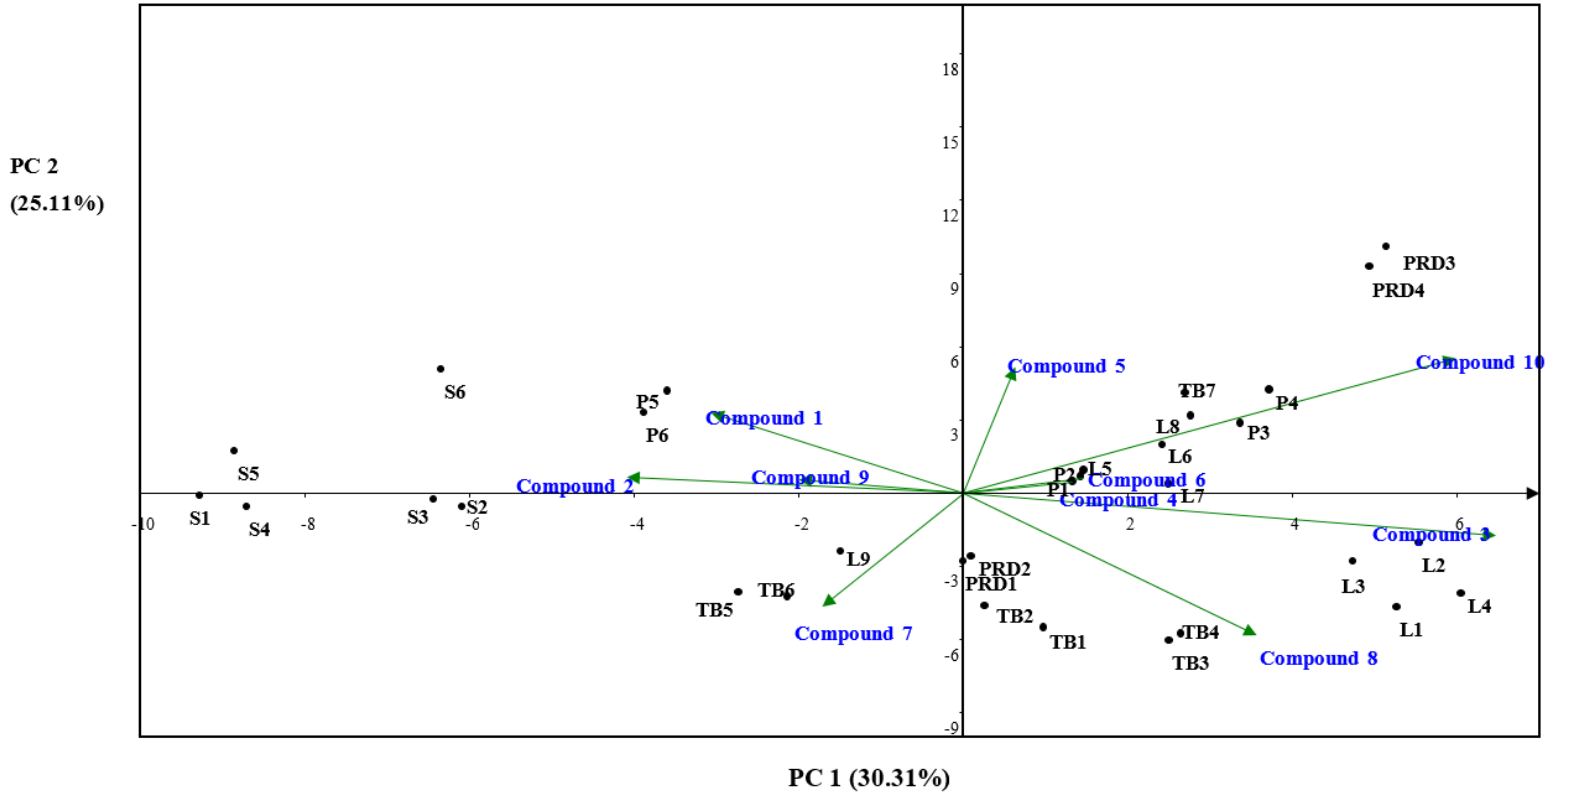
Figure 5. Principal component analysis (PCA) biplot for thirty-two M. oleifera samples.